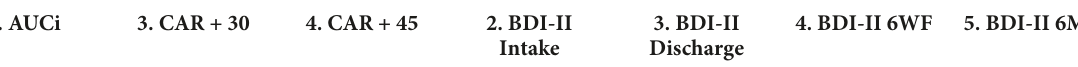
TABLE 3 Correlation between CAR and depressive pathology.